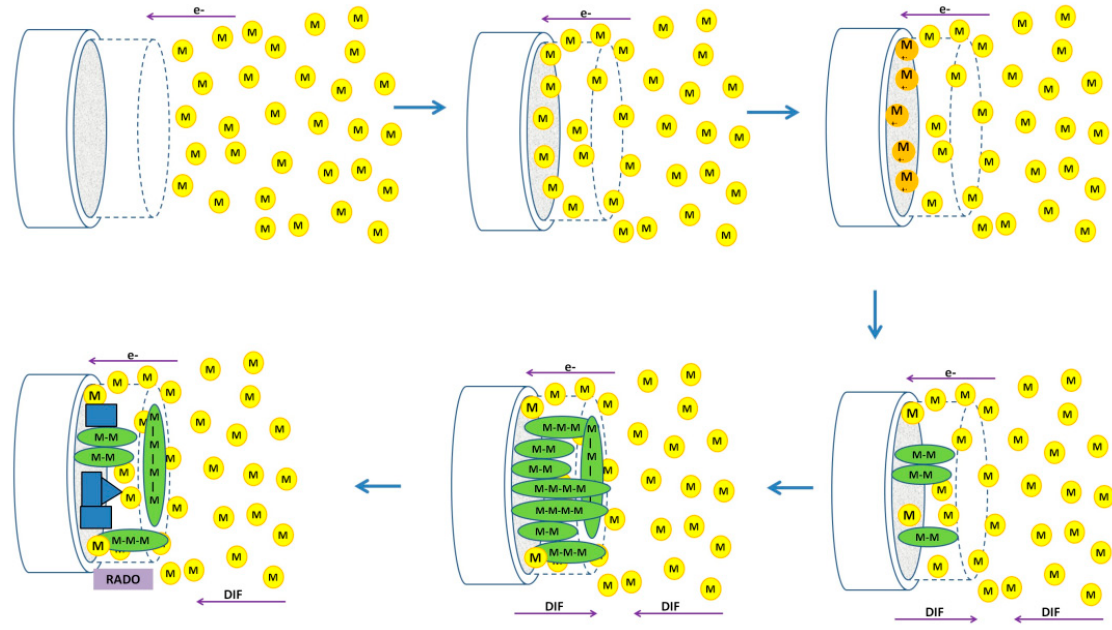
Figure 1. Proposed model for the electropolymerization process.